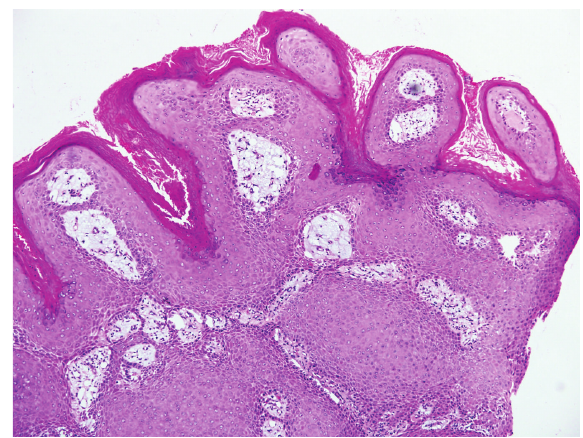
Figure 8: Verrucous hyperplasia: low power magnification view showing epidermal squamous proliferation with broad and super- ficial downgrowths of the epidermis. Overlying hyper-and paraker- atosis is present. There is no atypia or koilocytes. (H&E, × 100).